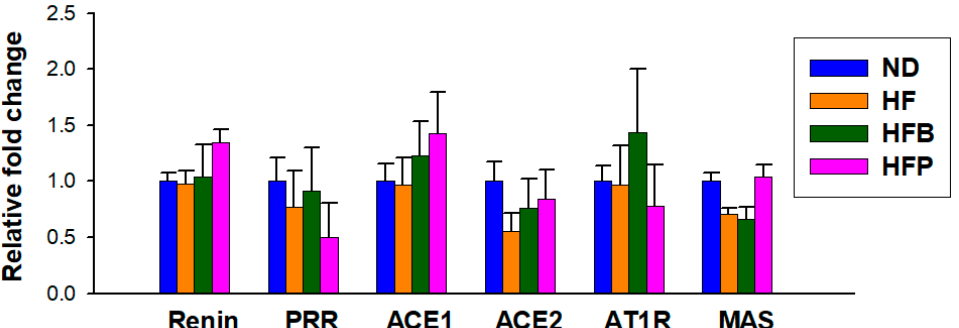
Figure 9. Renal mRNA expression of components belonging to the renin-angiotensin system of male offspring at age 12 weeks, including renin, (pro)renin receptor (PRR), angiotensin-converting enzyme-1 (ACE1) and -2 (ACE2), angiotensin II type 1 receptor (AT1R), and angiotensin (1–7) MAS receptor (MAS). N = 8/group.